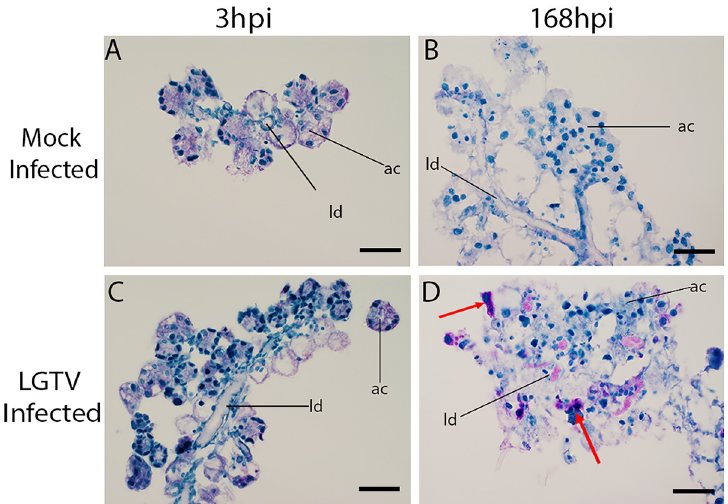
Fig 4. Immunohistochemical staining of LGTV-infected SG cultures from male ticks. We stained mock- and Langat virus (LGTV)-infected salivary glands (SGs) (infected at 5 x 10 5 focus-forming units) for detection of LGTV envelope (E) protein in LGTV-infected SG cultures from male Ixodes scapularis ticks. Images were taken at 40X magnification and display a single SG from a pool of 4 SG pairs per experimental group. Each SG measured approximately 1mm in length, and each granular acinus measured roughly 40–50 microns in diameter. Red arrows indicate E protein expression as denoted by deep purple coloring. ld–lobular duct, ac–acinus. Mock-infected samples were treated identically to LGTV-infected samples to allow for identification of potential nonspecific staining. Scale bars are representative of 40 microns.